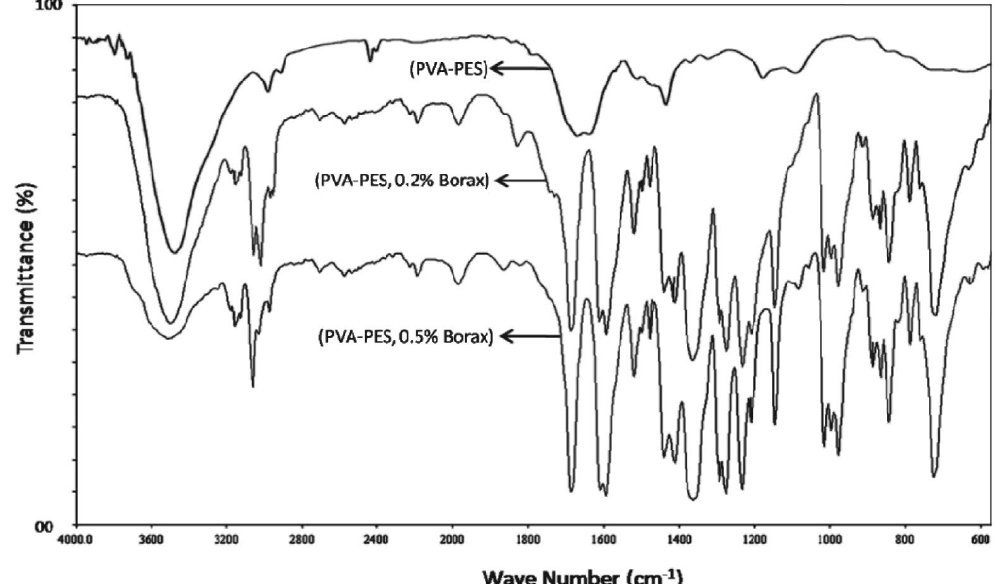
Fig. 2. FTIR spectra of PVA-PES composite membrane specimens cross linked with 0.2% and 0.5% borax as cross-linking agent used in the present